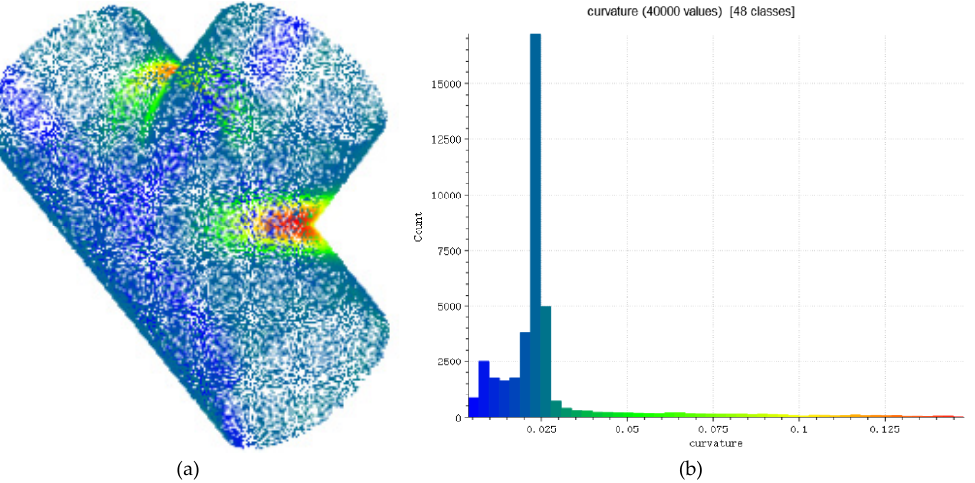
Figure 7. ( a ) is the curvature distribution of the three-way tube model. The color from red to blue corresponds to the average curvature of the point cloud from large to small. ( b ) is the curvature histogram of the three-way tube. According to the curvature histogram, we set 0–0.035 as the low-curvature range, and greater than 0.1 as the high-curvature